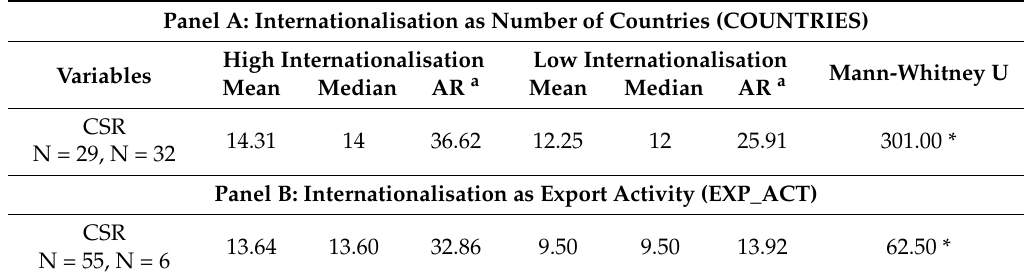
Table 5. Comparative analysis of CSR and Internationalisation